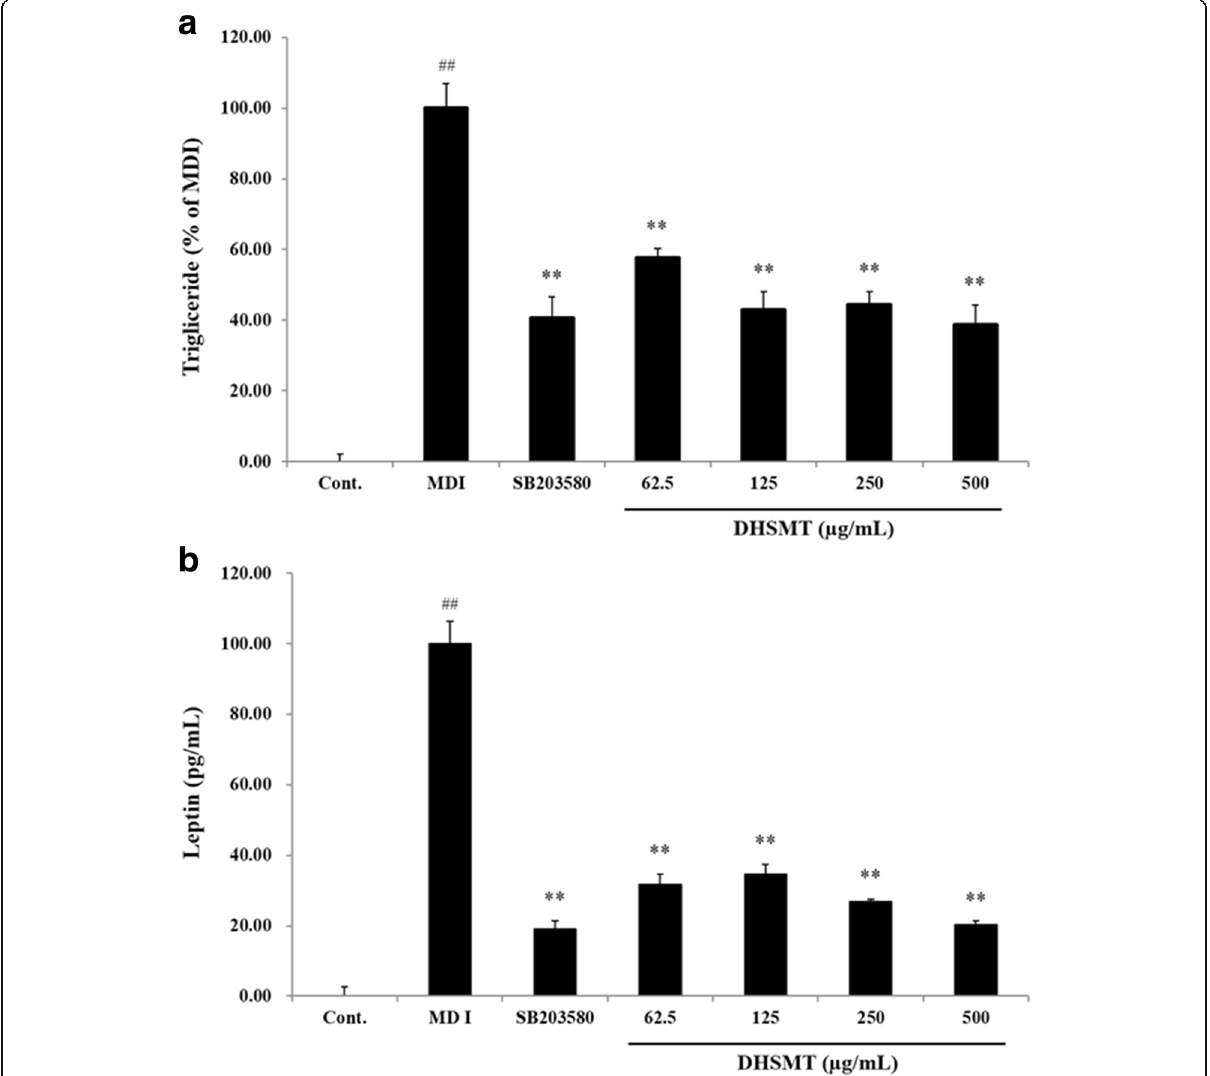
Fig. 4 Inhibitory effect of DHSMT on triglyceride (TG) and leptin accumulation in 3T3-L1 adipocytes. 3T3-L1 preadipocytes were differentiated into adipocytes by using a mixture of 3-isobutyl-1-methylisobutylxanthine, dexamethasone and insulin (MDI) with various concentrations of DHSMT (0, 62.5, 125, 250 and 500 μ g/ml) and SB203580 for 7 days. a TG content was measured enzymatically by using TG assay kit (Bioassay Systems, CA, USA). b Leptin production was measured at 450 nm by using a mouse leptin immunoassay kit (R&D Systems). The data are mean values of three experiments ± SEM; ## < 0.01 compared with control, * P < 0.05; ** P < 0.01 compared with the